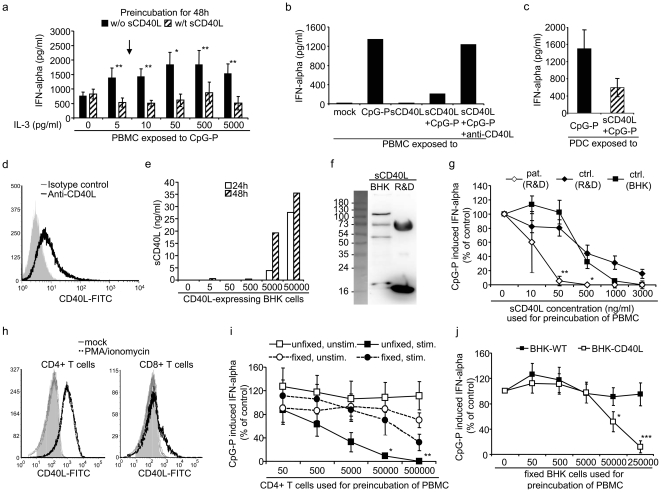
Suppression of interferon (IFN) alpha production by CD40 ligand.(a) Preincubation of peripheral blood mononuclear cells (PBMC) of controls without (w/o) or with (w/t) a cell-culture grade commercial soluble CD40 ligand (sCD40L; 3 µg/ml) for 48 hours (h), followed by stimulation with CpG-P 21798. Data represent 11 and 5 separate experiments for IL-3 levels of 0 and 5–5,000 pg/ml, respectively. The arrow indicates physiological IL-3 levels. (b) Neutralization of sCD40L with a cell-culture grade anti-CD40L antibody with subsequent CpG-P stimulation in two donors. Similar data were obtained using CpG-A (data not shown). (c) Direct effect of sCD40L (3 µg/ml) on the CpG-P induced IFN-alpha production by plasmacytoid dendritic cells (PDC) of control donors. (d) Expression of cell-associated CD40L (cCD40L) on baby hamster kidney (BHK) cells. (e) Shedding of sCD40L into the cell culture supernatants after 24 h and 48 h of culture. (f) Western Blot of concentrated supernatants of CD40L-expressing BHK cells and a commercial sCD40L preparation (R&D Systems) using reducing conditions. Data represent three separate experiments. No bands were detected in the supernatants of BHK wild type cells (data not shown). (g) Inhibition of CpG-P induced IFN-alpha production using sCD40L from R&D Systems and BHK cells. Statistics were calculated between PBMC of HIV-1 infected patients (pat.) (n = 5) and controls (ctrl.) (n = 10) exposed to sCD40L (R&D Systems). (h) cCD40L expression on CD4+ and CD8+ T cells of control donors after stimulation with mock (grey filled curve) or PMA/ionomycin (black dotted curve). (i) Inhibition of CpG-P induced IFN-alpha production by increasing counts of untreated (unstim.) or PMA/ionomycin-stimulated (stim.) CD4+ T cells, which were left unfixed or fixed used 4% paraformaldehyde, and coincubated with 1×106 PBMC of five control donors. Similar results were obtained with CpG-A (data not shown). (j) Inhibition of CpG-P induced IFN-alpha production by paraformaldehyde-fixed cCD40L-expressing and wild type (WT) BHK cells using PBMC of eight control donors. Data are presented as mean and standard error. *p<0.05, **p<0.01, ***p<0.001 (Student's t-test).